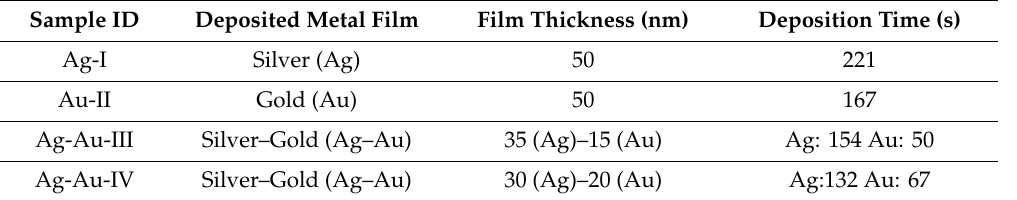
Table 1. Sample and